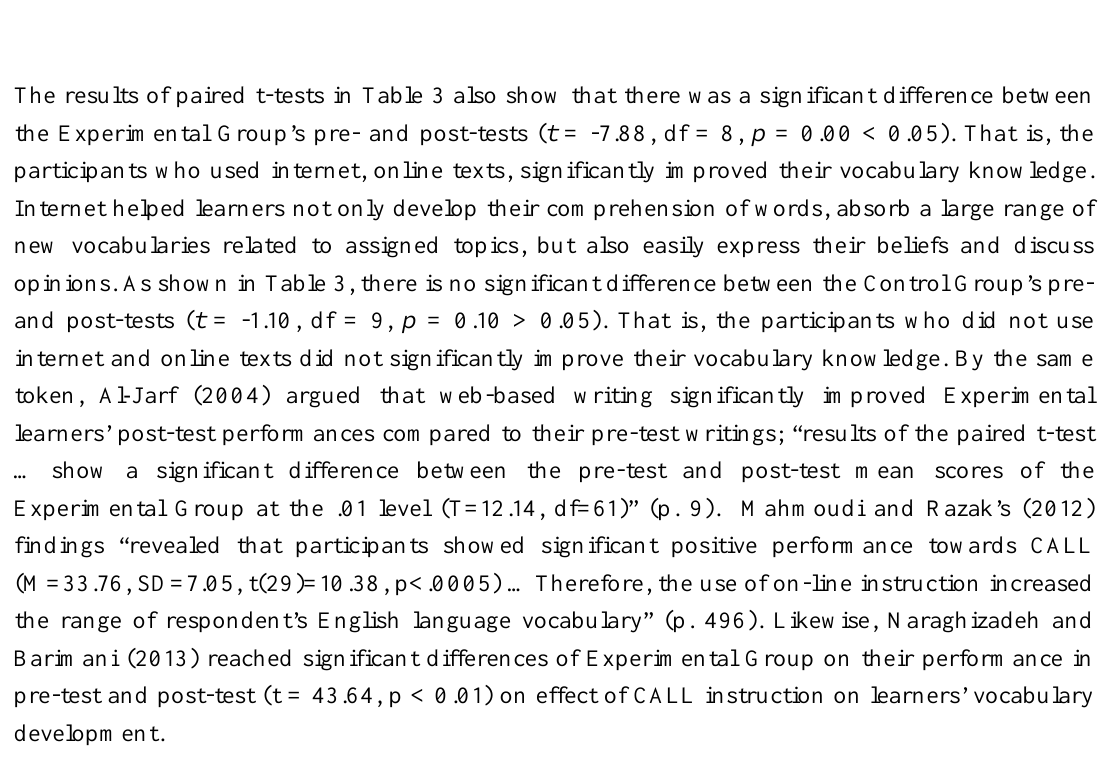
Table 2 The Independent Samples T-Test for the Experimental and Control Groups Experimental Control n= 9 n= 10 t p M SD M SD Pre-test 25.00 3.24 25.80 2.09 -0.64 0.52 Post-test 32.88 1.90 26.90 2.13 6.43